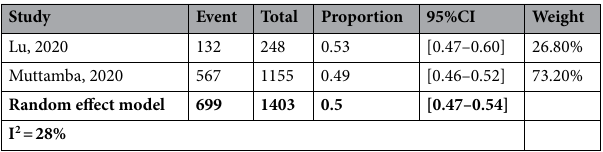
Table 9. Pooled proportion of Catastrophic Health Expenditure at 10%.